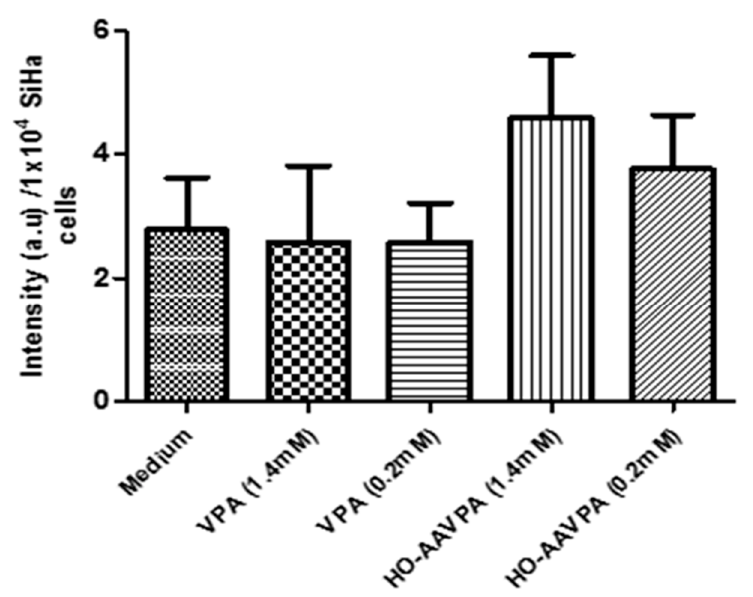
Figure 5. Measurement of ROS (O 2 − ·) levels by electronic paramagnetic resonance. SiHa cells were treated for 48 h with VPA or HO-AAVPA at two different concentrations: 1.4 and 0.2 mM. The intensity of the EPR signal is proportional to the ROS production and it was plotted against each one of the treatments. The values shown are the means ± SE of duplicate measurements from two independent experiments. No significant difference was obtained by one-Way ANOVA analysis and Dunnet as post-test comparing all treatment with the medium sample.